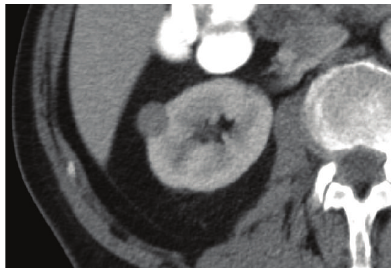
Figure 9: Papillary renal cell carcinoma. Contrast-enhanced CT shows small homogeneous mass that is mild and less enhanced than renal parenchyma